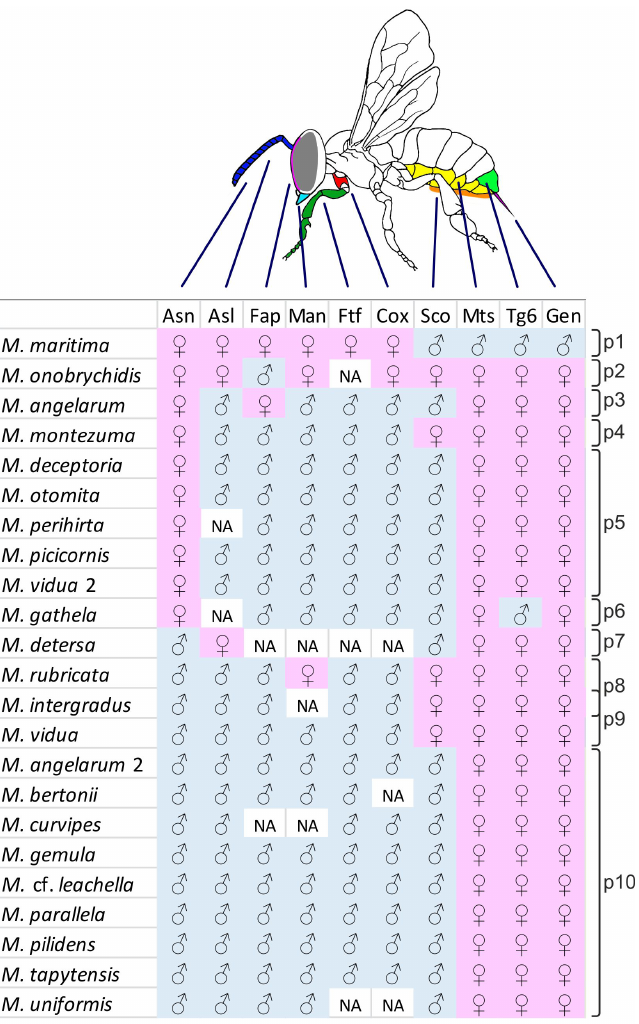
Figure 1. Gynandromorph patterns (p1–p10) observed in 21 Megachile species. Two different patterns have been recorded in M. angelarum (patterns 3 and 10) and M. vidua (patterns 5 and 9). Records with incomplete pattern description are assigned to a compatible pattern, when present. One species ( M. intergradus ) could equally be assigned to pattern 8 or 9. NA missing information. Asn, number of antennal segments; Asl, length of antennal segments; Fap, face pubescence; Man, mandibles; Ftf, font tarsi and/or femora; Cox, front coxae; Sco, scopa; Mts, metasoma segments; Tg6, sixth dorsal tergite; Gen,